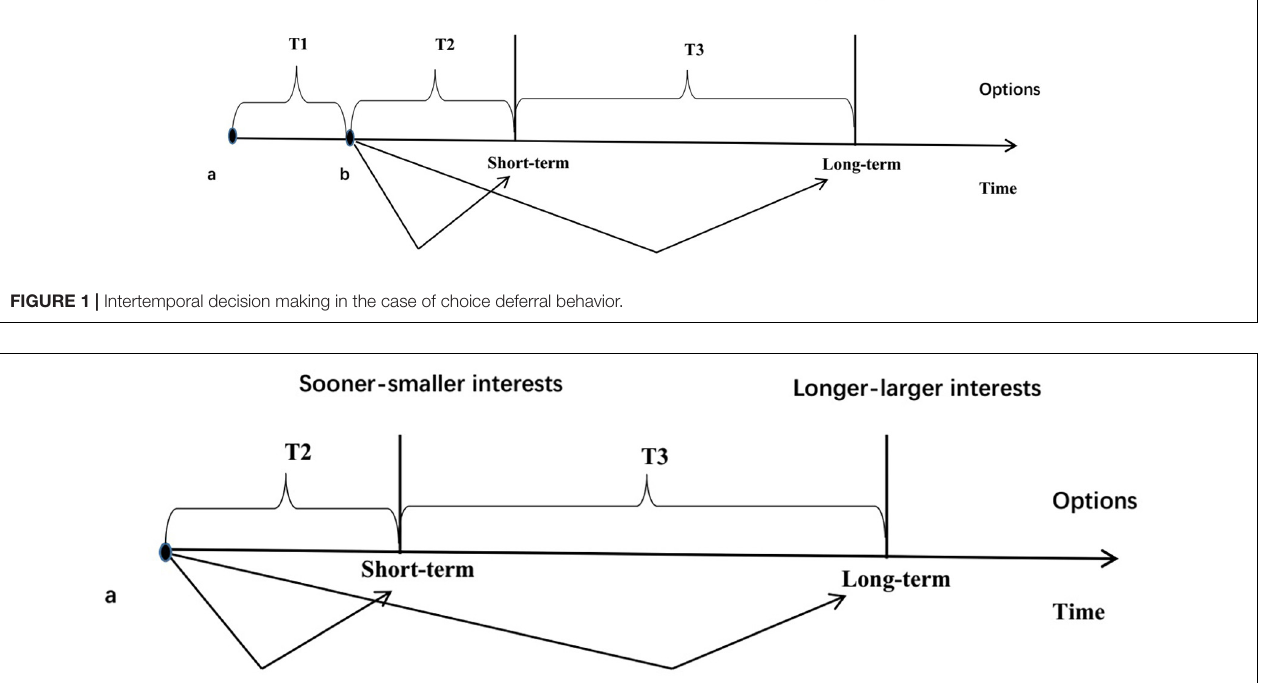
FIGURE 2 | Intertemporal decision making in the case of non-choice deferral behavior.